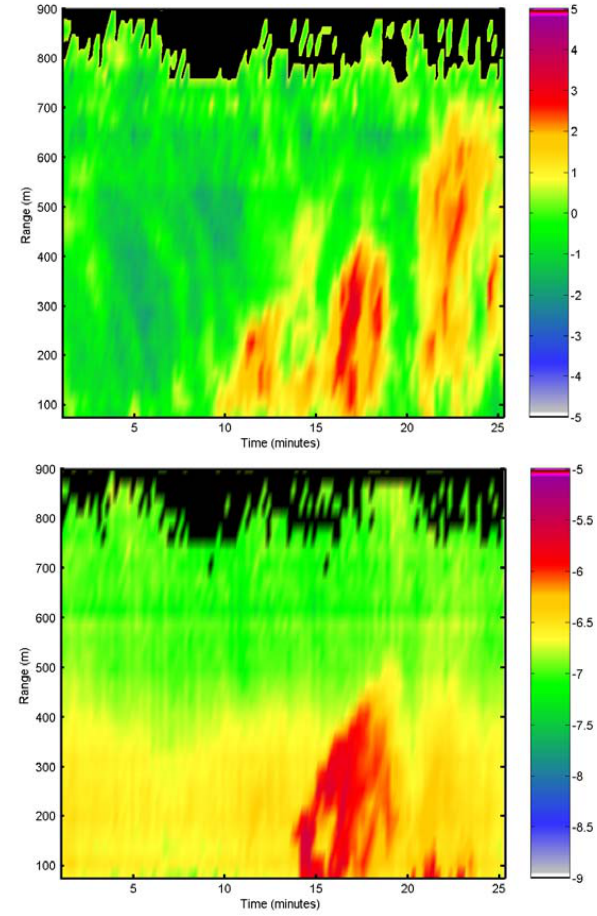
Fig. 3. An example of a 25min observation of the vertical velocity (upper panel) and aerosol backscatter coefficient (lower panel). The start time was 11:05LT on 24 April 2008. The colour scales in the upper and lower plots are ms − 1 and log backscatter (m − 1 sr − 1 ) respectively. Updrafts are designated positive velocity.